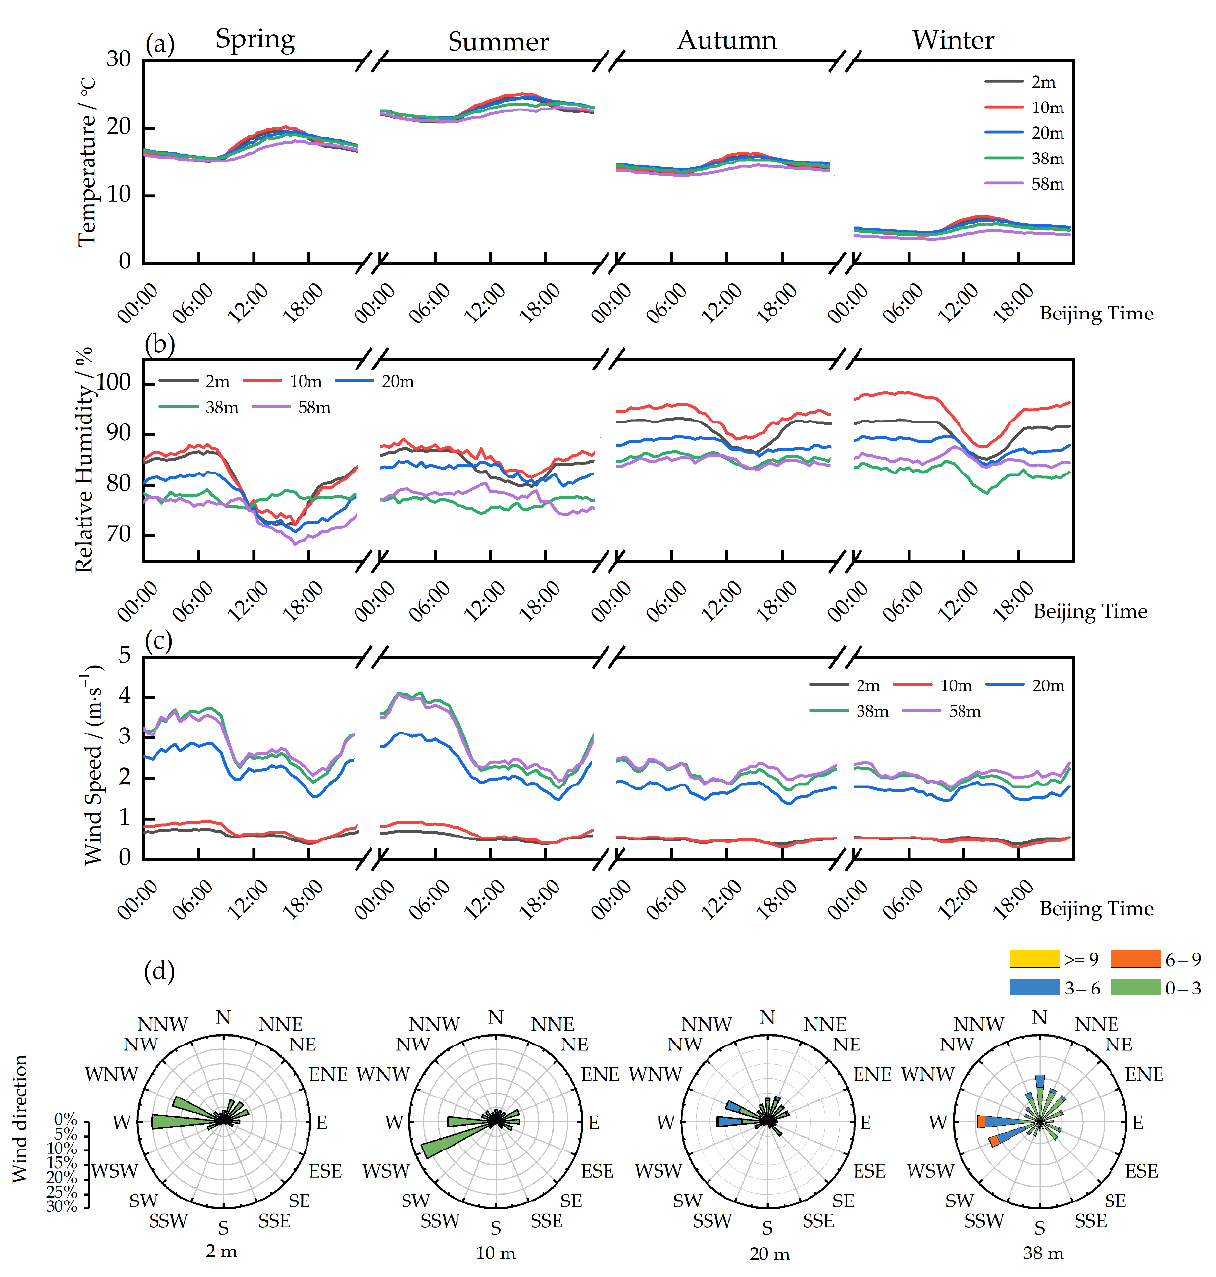
Figure 2. ( a ) Seasonal average daily variation of temperatures in the near-surface layer; ( b ) seasonal average daily variation of relative humidity in the near-surface layer; ( c ) seasonal average daily variation of wind speed in the near-surface layer; ( d ) wind frequency diagram for the near-surface layer.